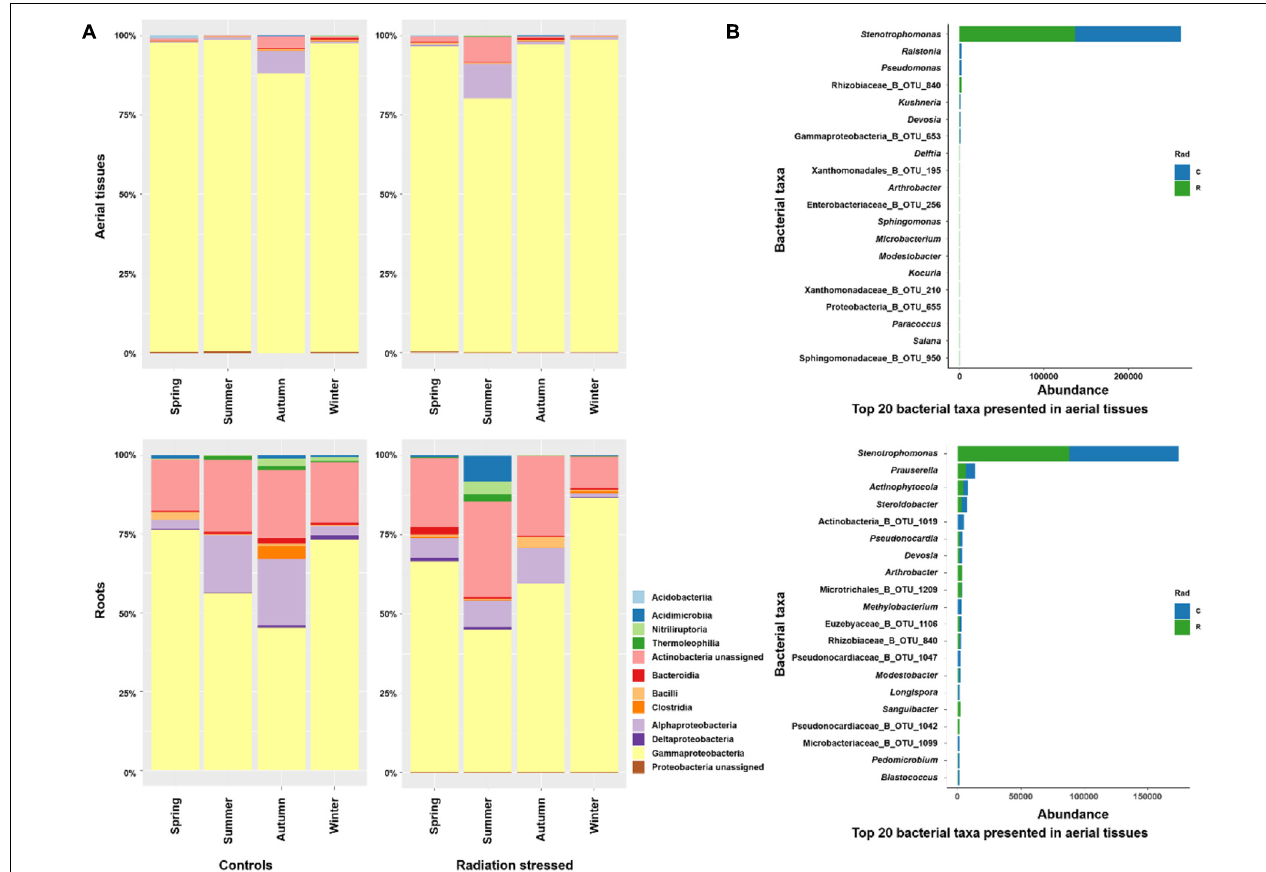
FIGURE 1 | Taxonomical composition of endophytic bacteria in Kalidium schrenkianum . (A) Relative abundance of top 12 bacterial phyla presented in aerial tissues and roots over different seasons at two sampling sites. (B) The abundance of top 20 bacterial genera or OTUs in aerial tissues (upper) and roots (bottom). The blue bars indicate bacterial abundances in the control site, whereas green bars indicate abundances in radiation stressed